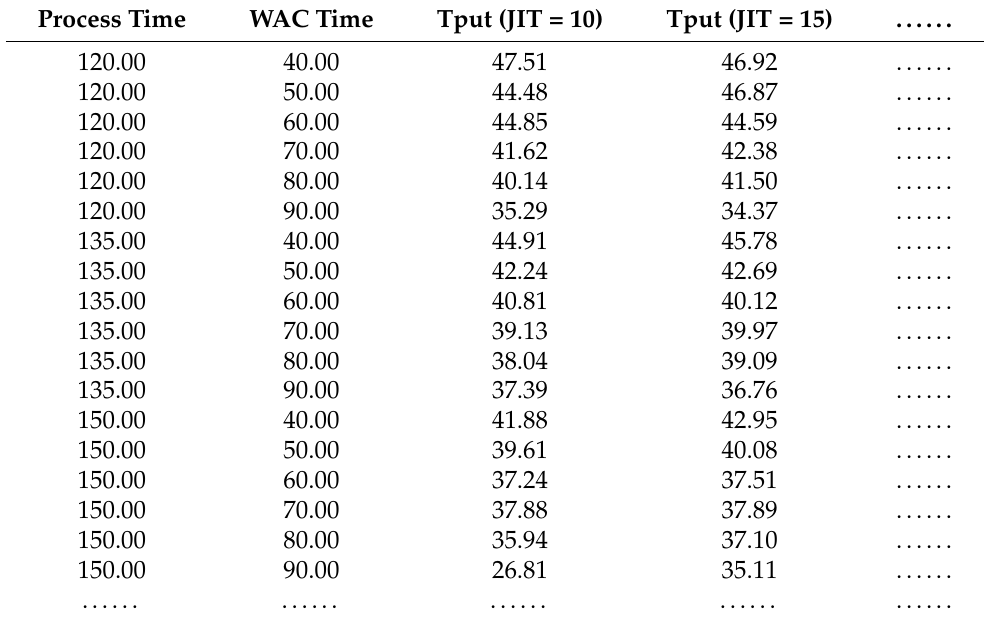
Table 1. Cluster tool throughput simulation